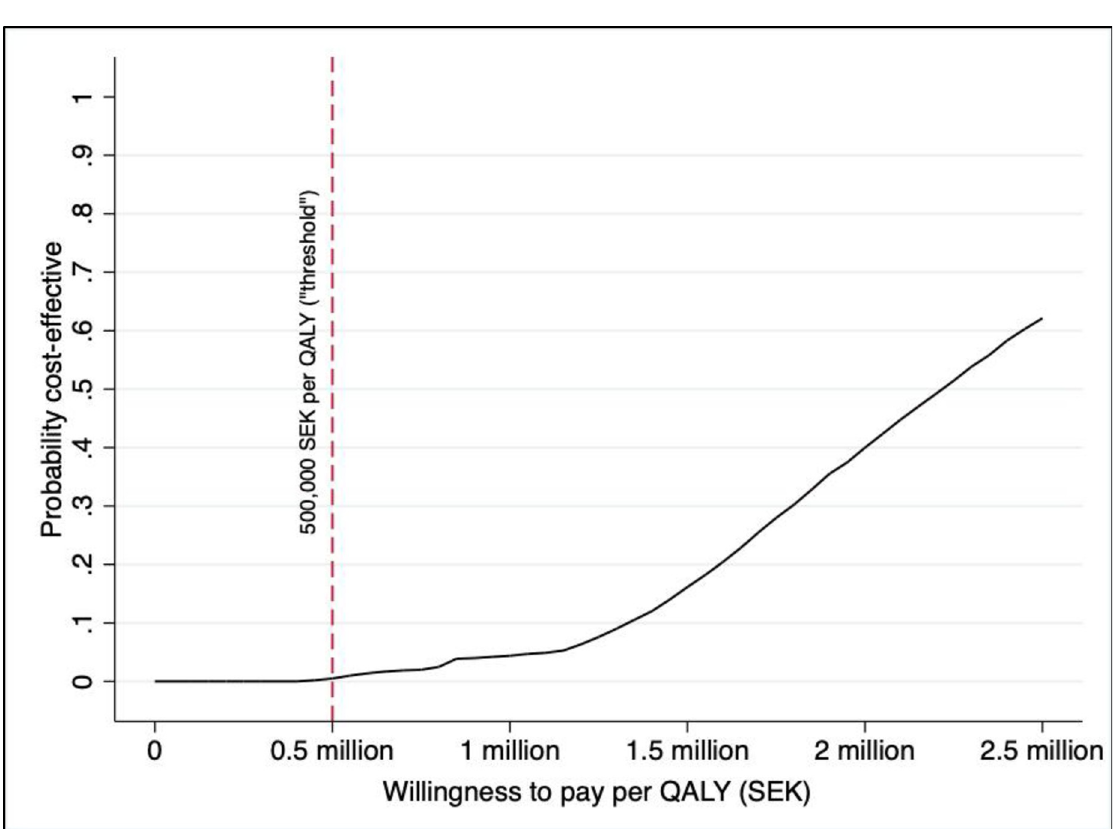
Fig 4. Cost-effectiveness acceptability curve based on probabilistic sensitivity analysis.